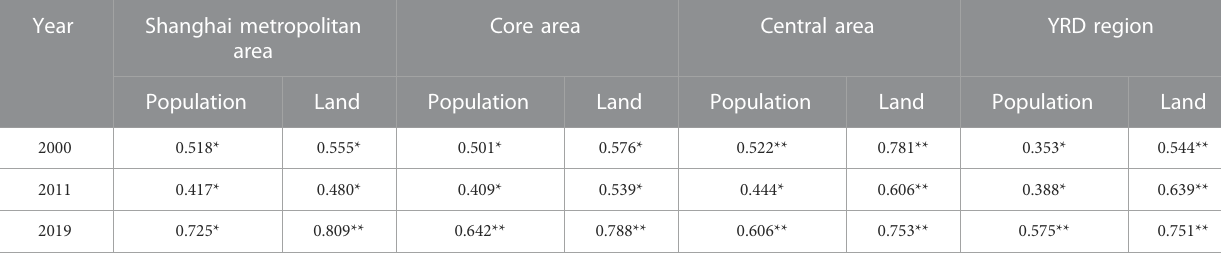
TABLE 4 Pearson correlation analysis of population-land and economic agglomeration in the YRD.